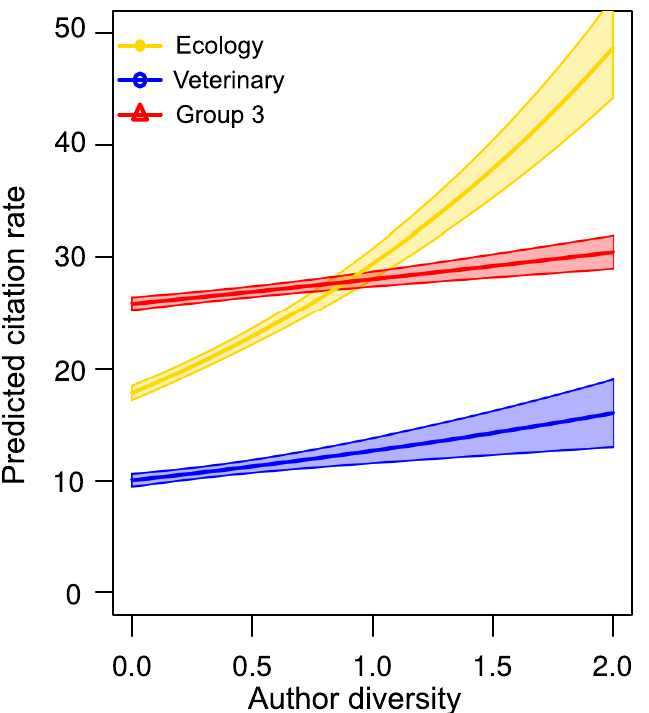
Fig 5. Citation benefits of author diversity. Associations between author diversity and citation rate for papers in each journal community. Model estimates are derived from a Poisson mixed effects model with an offset term for years since publication, and coefficient estimates are reported in S8 Table. Predictions are calculated for papers published in 2010, with 25% of citations to other journal communities and 75% of citations to the paper ’ s own community. Data to generate this figure are contained in S1